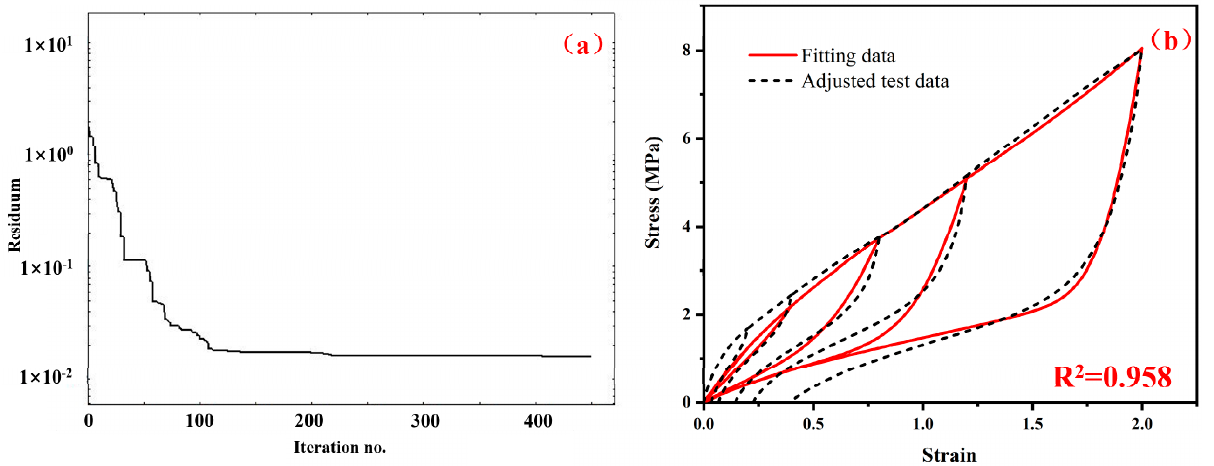
Figure 6. ( a ) The relation between the residuum value and the iteration number in the parameter identification process, and ( b ) comparison between the adjusted stress–strain data and the fitting results using the optimized material parameters of the hyper-pseudoelastic constitutive model.